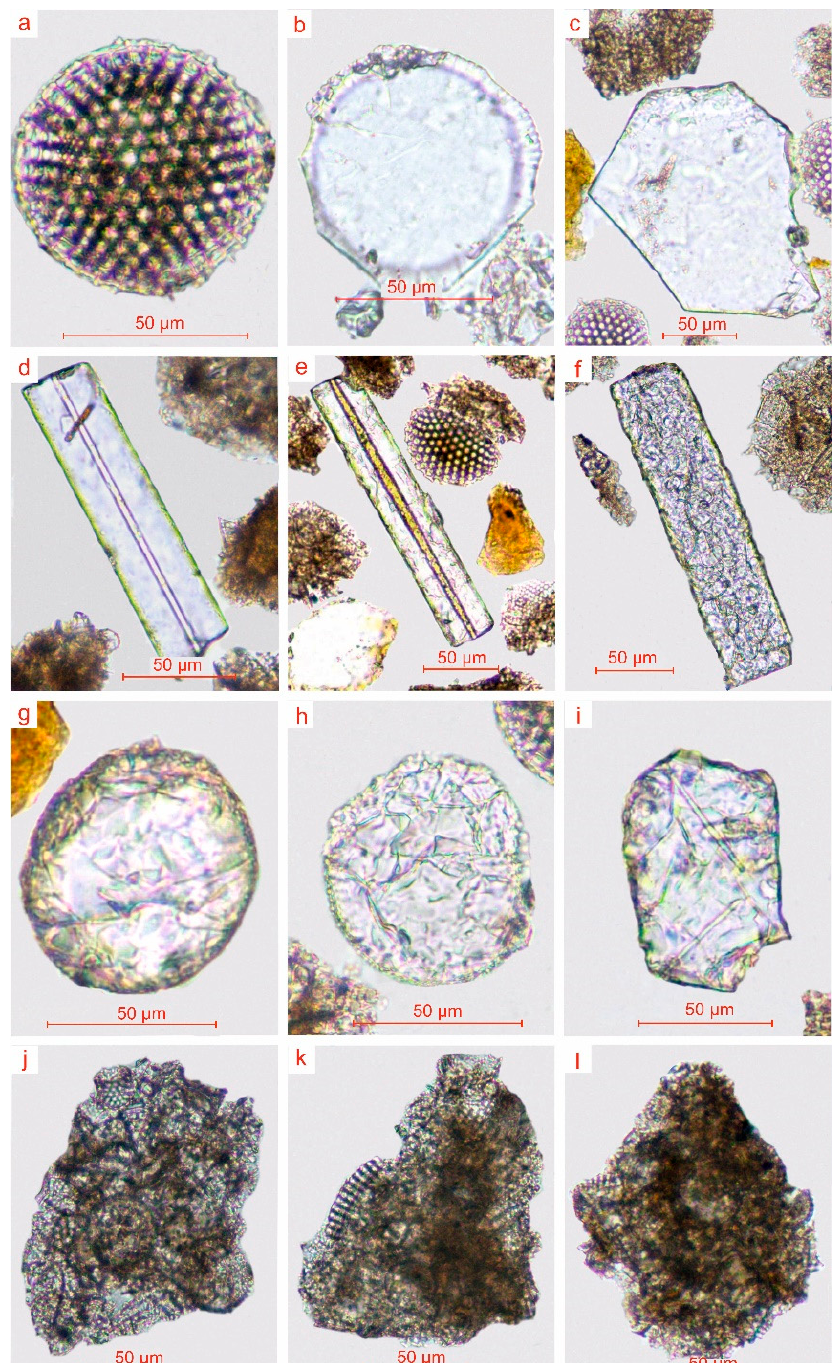
Figure 5. Biosiliceous components and the products of their transformation: Irbit deposit: ( a ) diatom valve; Shadrinsk deposit: ( a , b ) diatom valve recrystallized in tridymite, with newly-formed faces (fraction 0.01–0.1 mm); ( c ) tridymite crystal; ( d–f ) spicules of sponges: ( d ) sponge spicule in the axial channel, filled with a liquid; ( e ) sponge spicule with the axial channel, filled with Fe-rich illite; ( f ) spicule, altered and acquired globular structure; ( g–i ) fragments of sponge spicules, altered and morphologically different diatom detritus and grains of clayey minerals; ( j–l ) mixed clayey–siliceous aggregates.